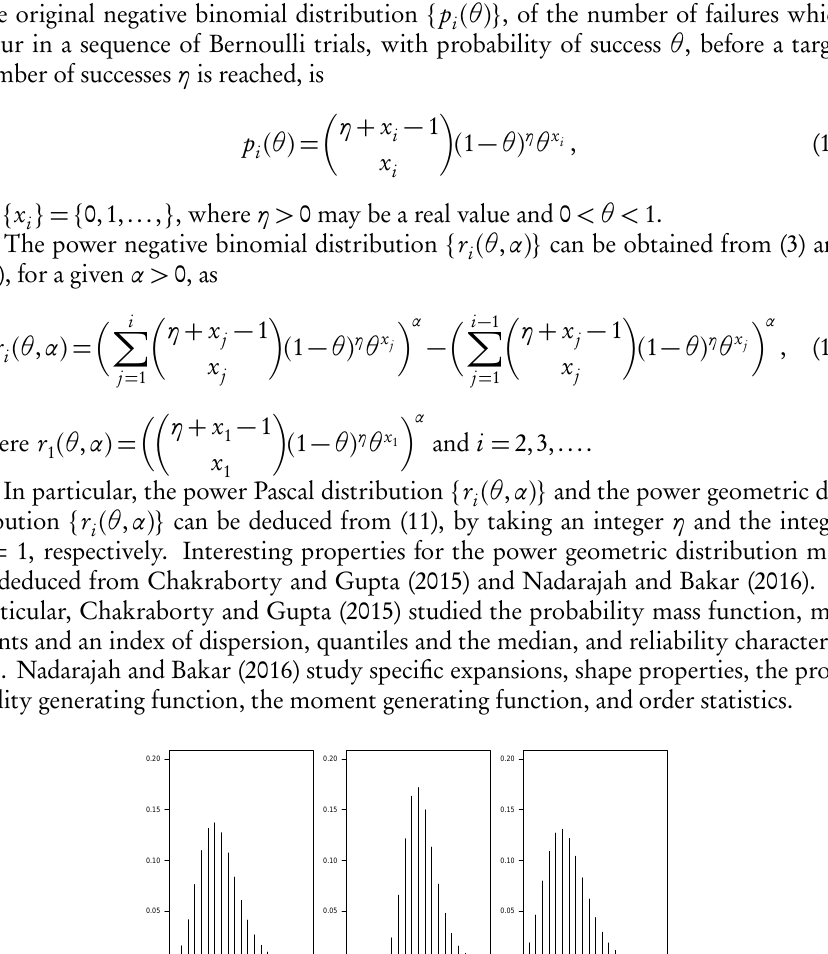
Figure 7 – An original negative binomial distribution { p θ = 0.75, and power negative binomial distributions { r 5.32, in panel (b), and for η = 6.67, θ = 0.75, and α = 0.69, in panel